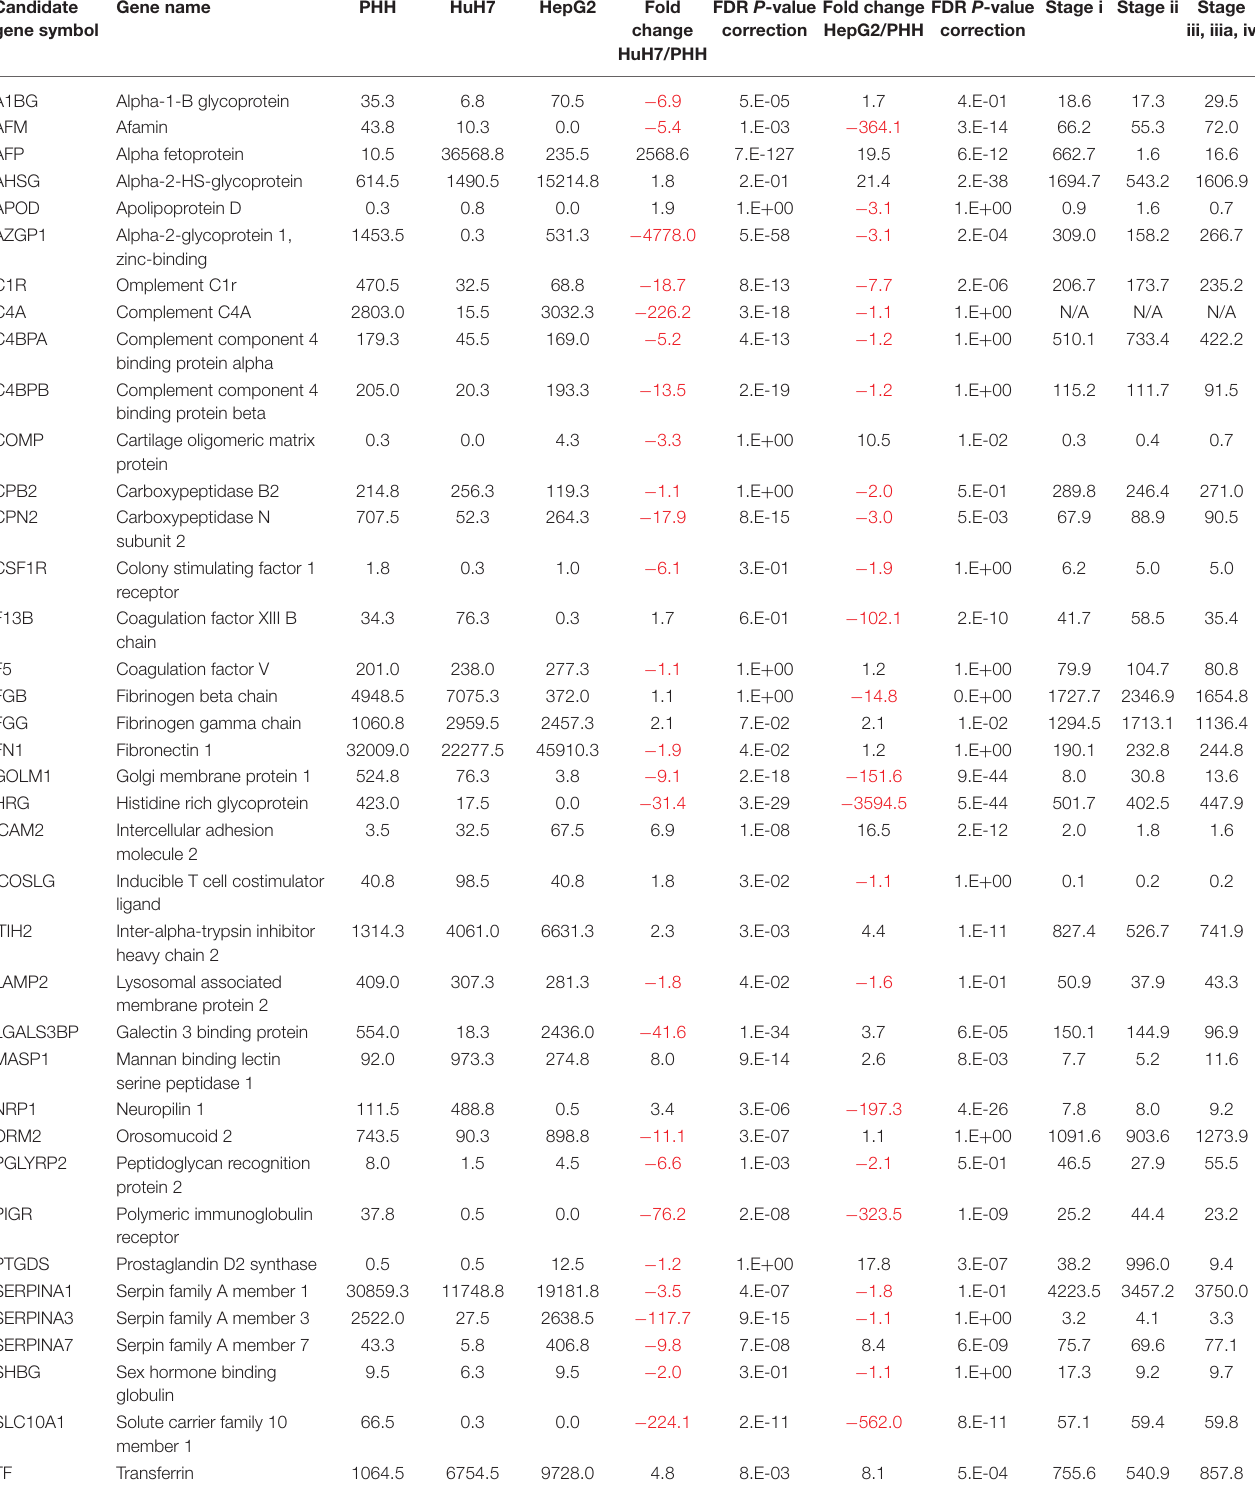
TABLE 1 | Expression of biomarker candidates*. Candidate Gene gene symbol